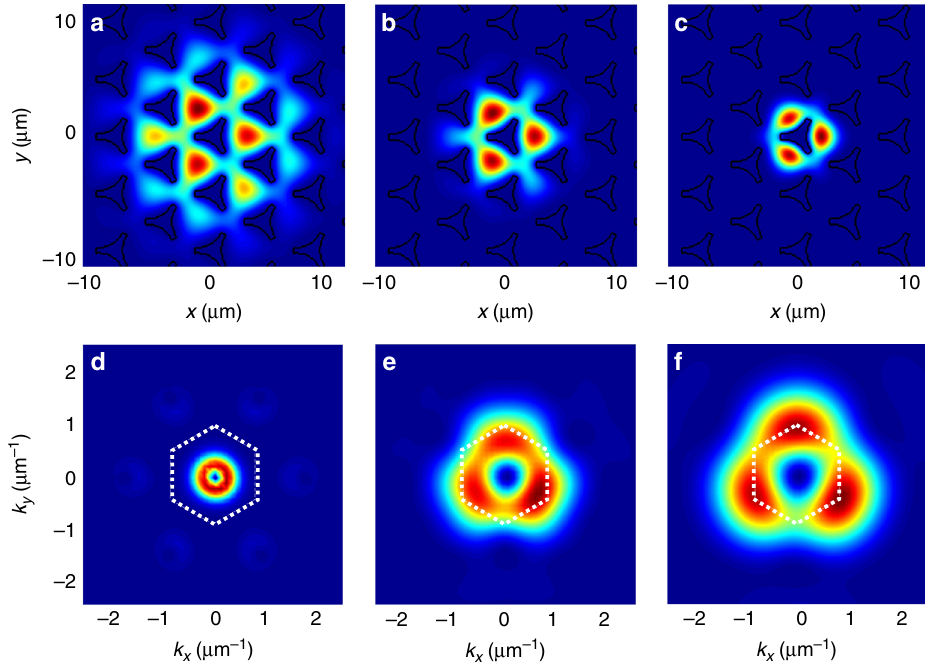
Fig. 1 Valley-Vortex winding coupling. Numerical density pro fi le of the vortex stationary solution in real ( a – c ) and reciprocal ( d – f ) space for different fi ltering scales ( w = 7, 3, 1 μ m, respectively)